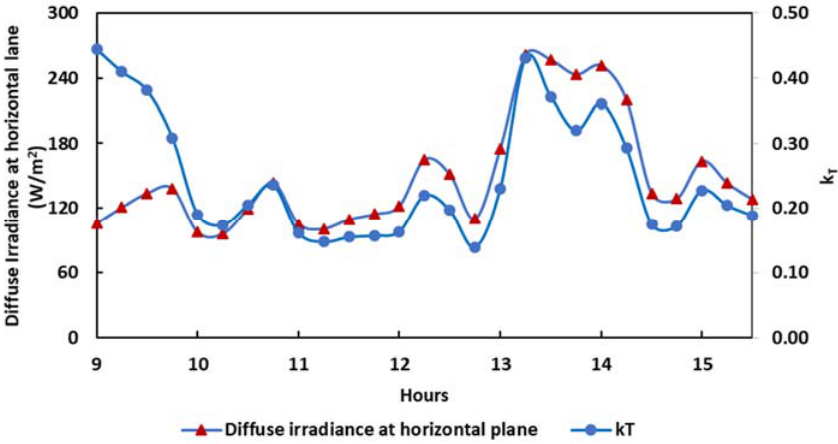
Figure 7. The k T and diffuse irradiance at the horizontal plane values during the outdoor experiment.